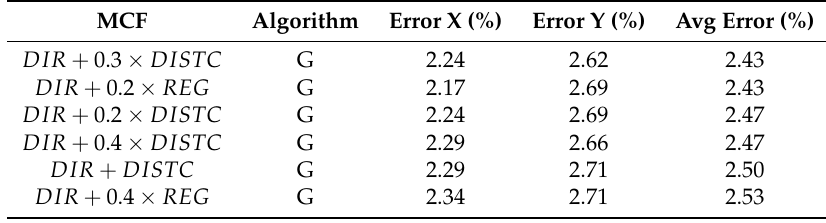
Table 5. Average errors for various MCF fusions calculated for GT saliency and removalPercent = 20%. Only fusions that gave results better than the baseline MCF DIR ( g ) are listed.